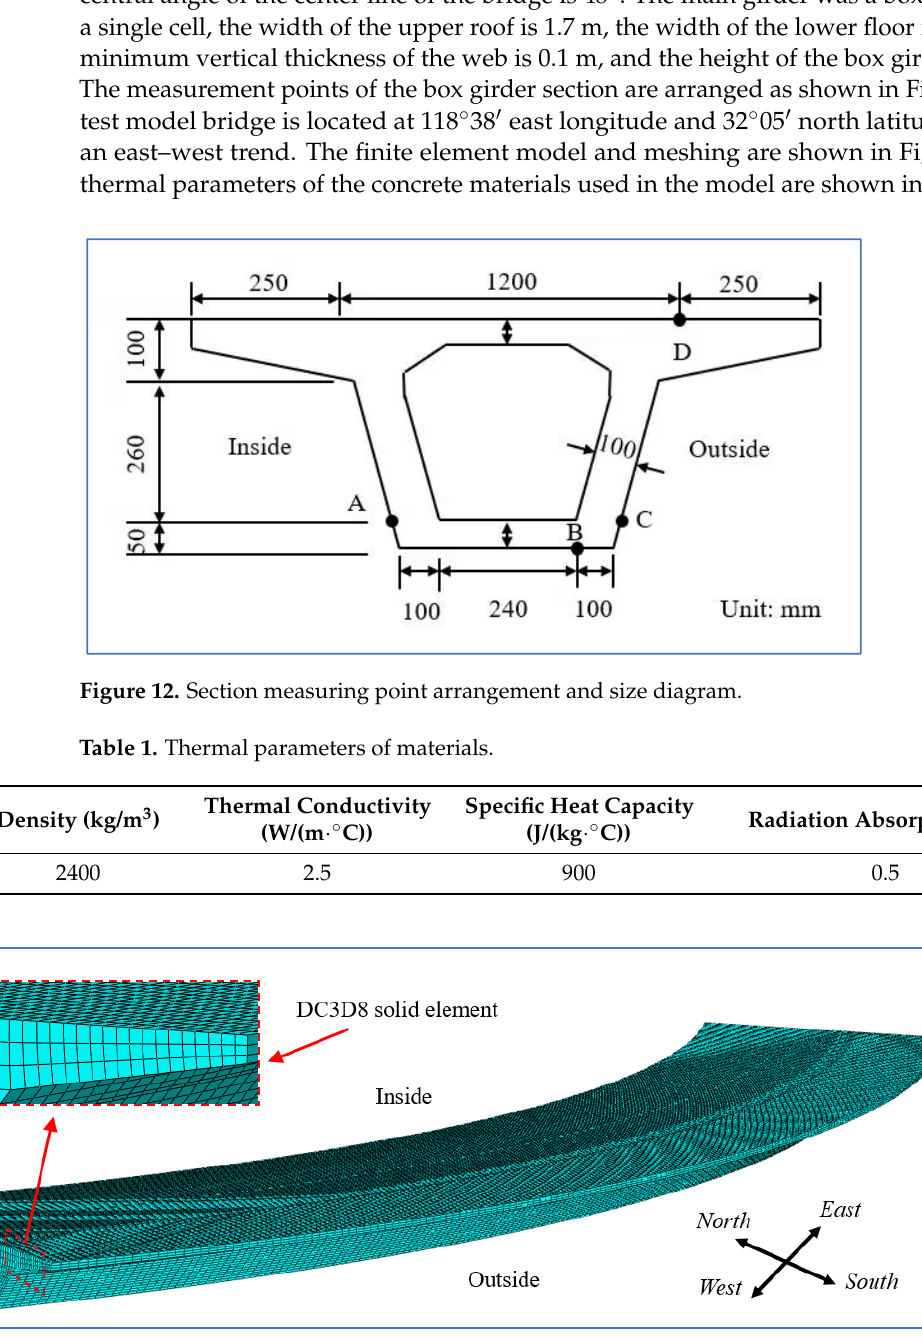
Figure 11. Sunshine shadow display operation process.